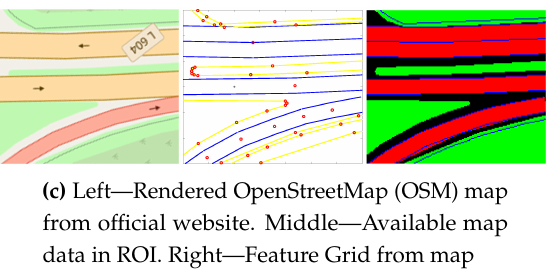
Figure 3. Example of modeling data from different sources using feature grid representation: cells with road labels (red), cells with lane marking labels (blue), cells with other surface labels (green), cells with unclassified labels